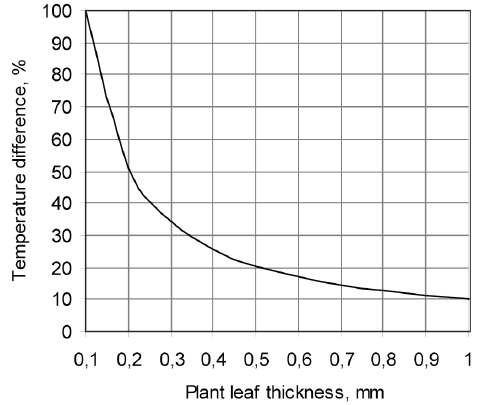
Fig. 5. The dependence of temperature change on plant leaf thickness in